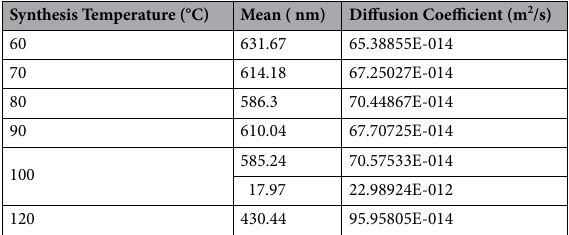
Table 2. DLS results about synthesis temperature-size relation of TiO 2